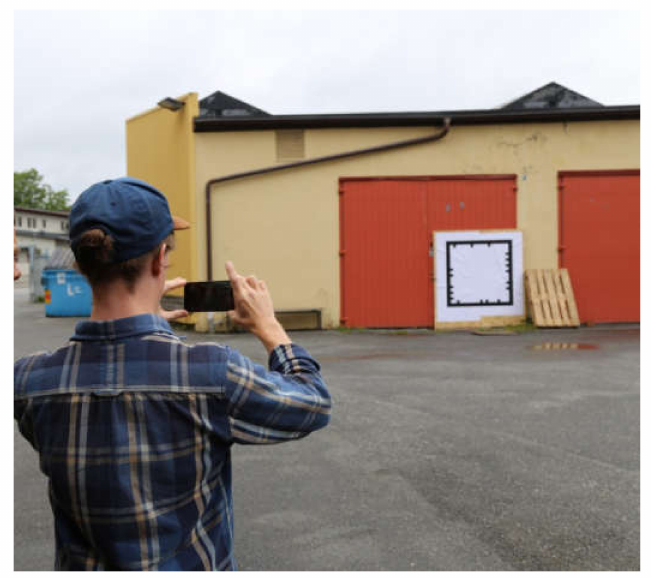
Figure 4. Printed bitonal frame marker used during test of